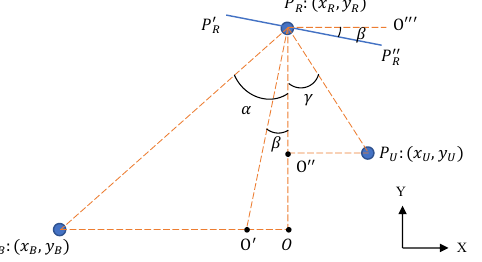
Figure 2. Assumed locations of the base station, the IRS and the user